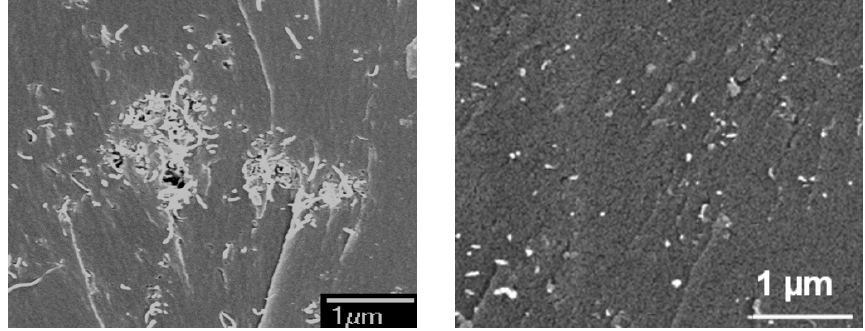
Figure 13 . SEM images of fracture surface of epoxy containing 0.5 wt.% pristine carbon nanotubes (CNTs) ( left ) and amino-CNTs ( right ). Reproduced with permission from [54]. Elsevier, 2010.